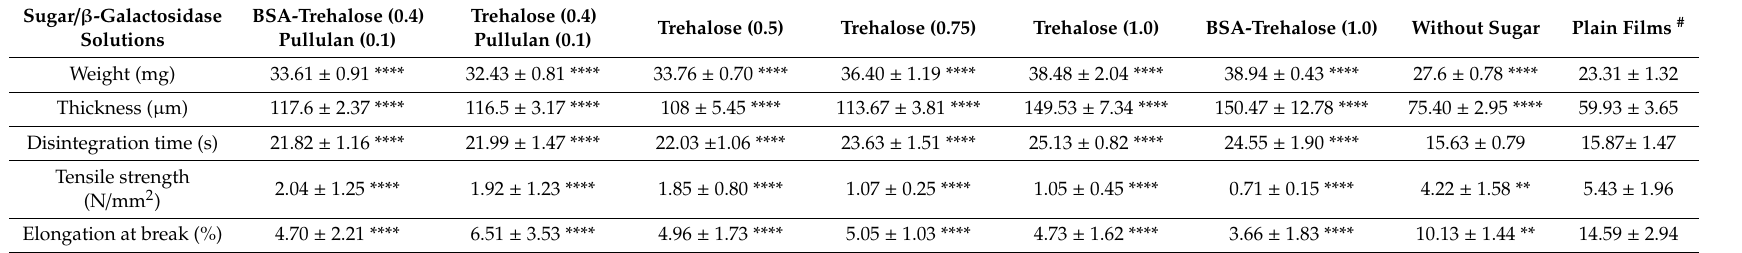
Table 4. Mass, thickness, disintegration time, and mechanical properties of vacuum-dried ODFs with β -galactosidase. Sugar / β